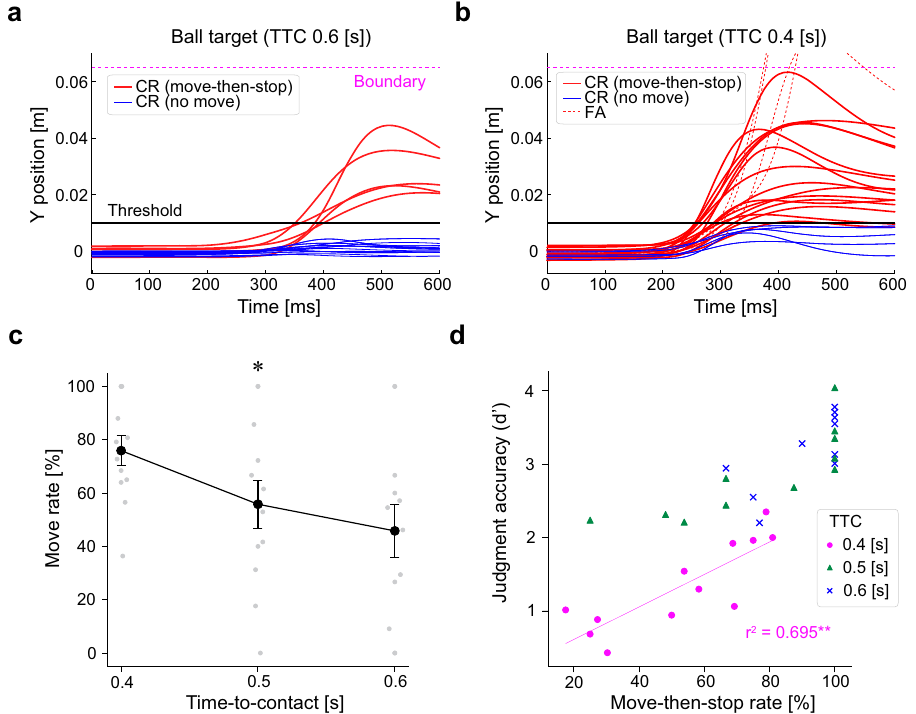
Fig. 4 TTC-dependent changes in No-go behavior and their impact on judgment accuracy. a , b Example of Y position pro fi les of Ball targets in J task in a representative participant. The Y position pro fi les for CR (move-then-stop) trials, CR (no move) trials, and FA trials are plotted as red lines, blue lines, and red dashed lines, respectively, for 0.6 s ( a ) and 0.4 s TTC ( b ). The magenta dashed line indicates the Go/No-go boundary and the black line indicates the threshold that determined whether the cursor moved or not. c The mean move rate of CR trials for each TTC in J task (Mean ± SEM, n = 12) shown by black lines with individual data points overlaid. There is a signi fi cant main effect for TTC (* p < 0.05). Please note that due to the decrease in TTCs, participants did not hold the hand stationary, but moved their hand once and then stopped it when No-go judgement was required. d Relation between the success rate of move-then-stop trials and judgement accuracy (d ′ ) for each TTC in individual participant (0.4 s: magenta circle, 0.5 s: green triangle and 0.6 s: blue cross). The magenta line shows the regression line in 0.4 s TTC plots and r 2 represents the coef fi cient of determination. ( n = 12, ** p < 0.01). Please note that the move-then-stop strategy is effective in suppressing No-go judgement mistake under severe time